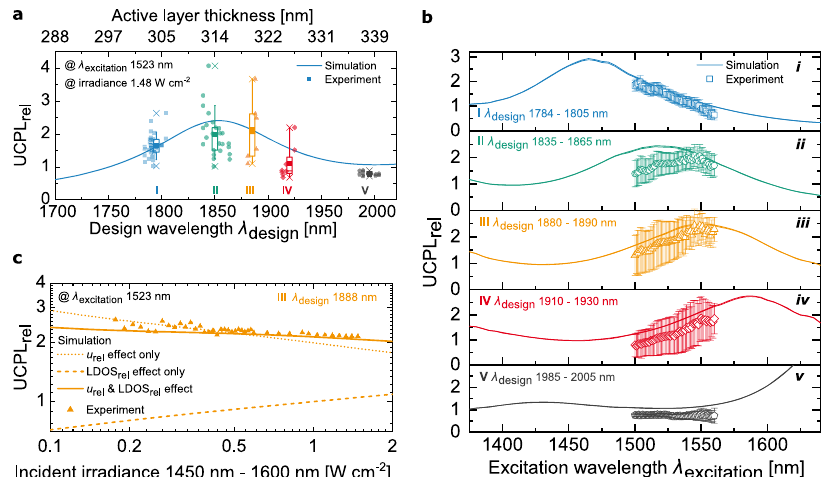
Fig. 4 Effect of varied parameters on the relative upconversion photoluminescence (UCPL rel ) − comparison of simulation and experiment. a We investigate the dependence of UCPL rel on the design wavelength λ design using 40 sample designs around the expected maximum UC enhancement, sorted into fi ve groups (I – V) of similar λ design . Two measurements of each investigated design are plotted, the boxes contain 50%, the whiskers 80% of the data points within each group. Point and horizontal line represent mean and median, respectively. b Scanning the excitation wavelength λ excitation , the mean and standard deviation of UCPL rel within each group I – V is plotted. The applied irradiance in experiment lies between 1.57 W cm − 2 at λ excitation = 1500 nm and 1.38 W cm − 2 at λ excitation = 1560 nm. The simulation is plotted for the center λ design of each group at these two boundary irradiances. c Effect of varied irradiance for one sample design of group III, compared to simulation of UCPL rel including only one photonic effect, of the changed local energy density u rel or the modi fi ed local density of optical states LDOS rel , or both effects. For all investigated parameter scans ( a – c ), the expected trends from simulation are clearly visible in experiment. In the mean of all 2480 measurements at separate parameter combinations, the experimentally measured UCPL rel divided by the simulated UCPL rel is 82 ± 24%, featuring a very good agreement. Source data for a and b (i – v) are provided as a Source Data fi top x -axis of Fig. 4a. The simulated UCPL rel is the same as in Fig. 3e, including the standard deviation of the layer thicknesses